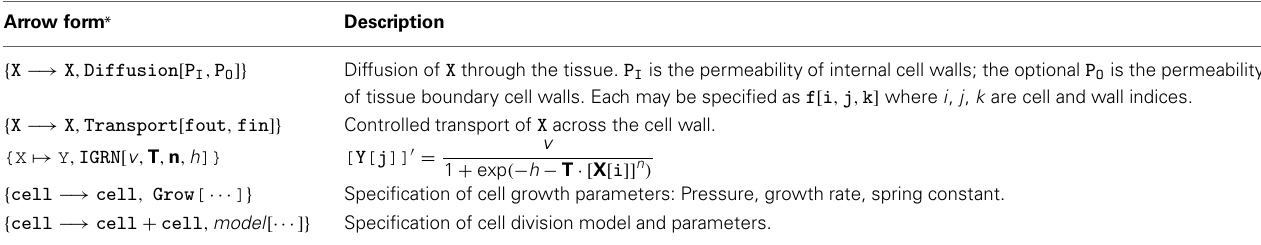
Table 3 | Additional Cellzilla arrow forms not recognized by Cellerator. Arrow form *